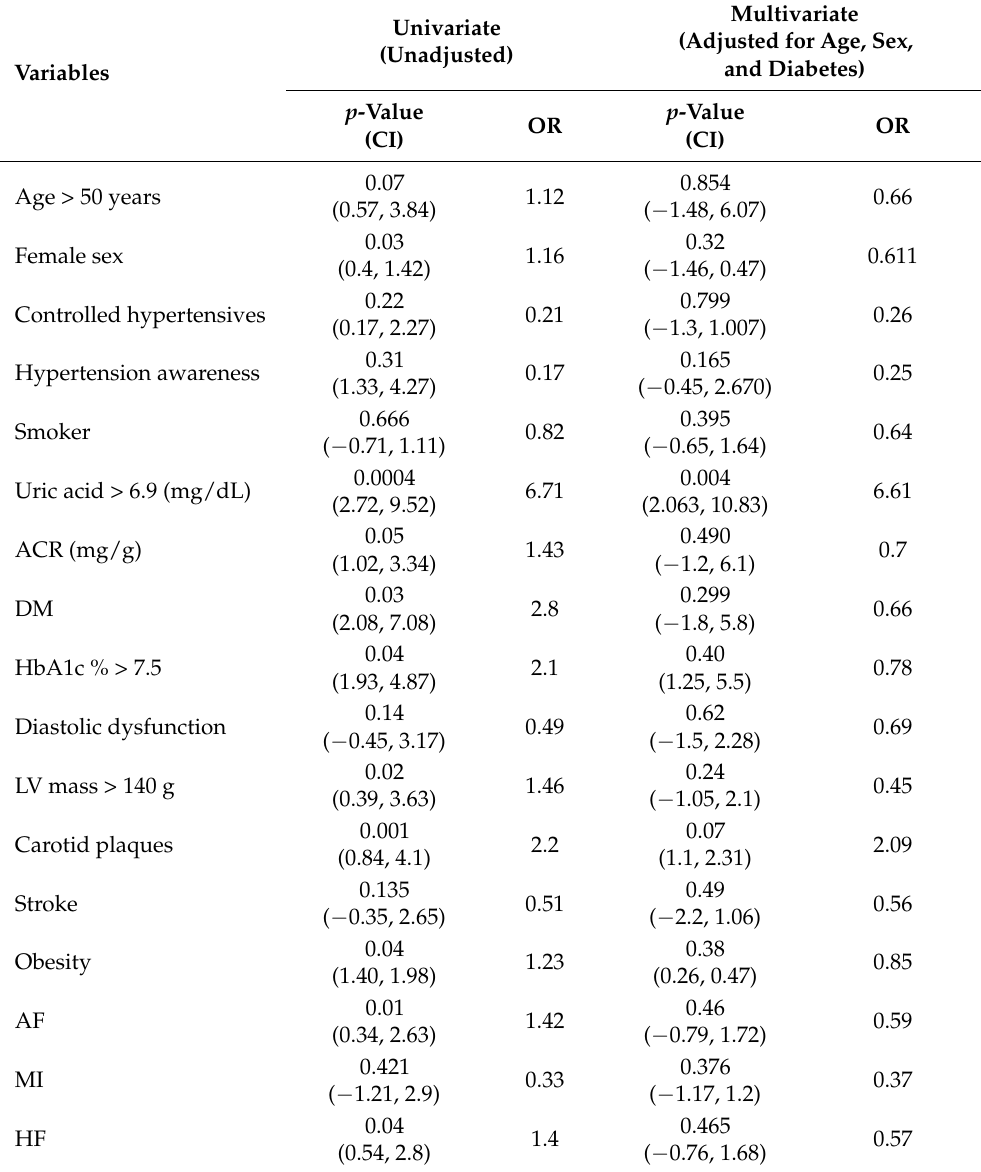
Table 4. Predictors of CKD in patients with hypertension adjusted for sex, age, and DM. Legend: IACR—urinary albumin-to-creatinine ratio, DM—diabetes mellitus, HbA1c—hemoglobin glycated A1c, LV—left ventricle, AF—atrial fibrillation, MI—myocardial infarction, HF—heart failure, p ≤ 0.05, CI—confidence interval (95% confidence level), OR—odds